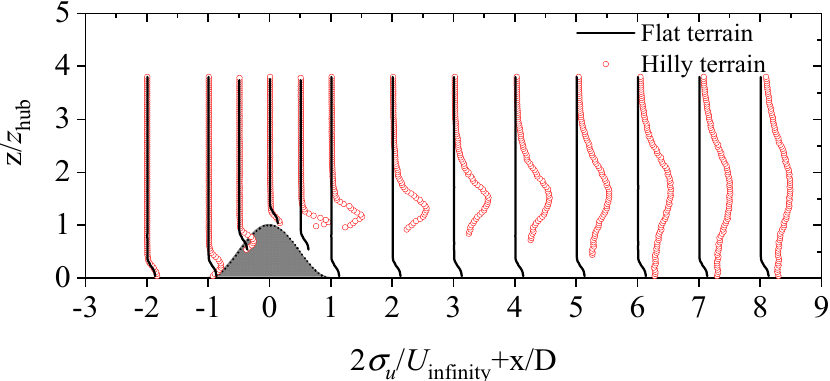
Figure 9. Turbulence intensity at various locations around a single two-dimensional cosine hill. It can be concluded that for the hill with larger slopes, the turbulence at the height close to the hill and the region behind the hill still remain at a high level in the test range.